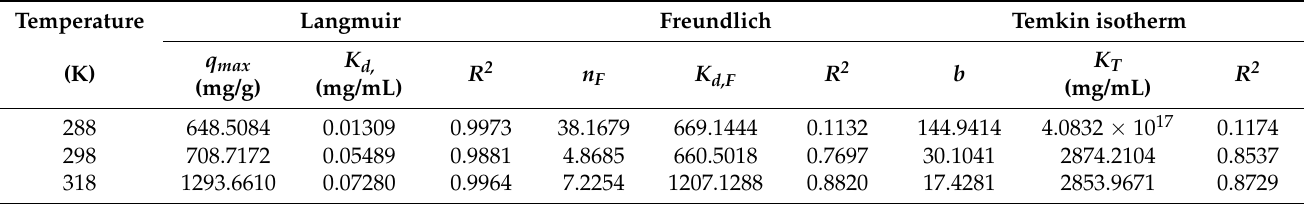
Table 4. Equilibrium and thermodynamic parameters calculated using equilibrium isotherm models for determining the adsorption behavior of P-COOH-CS-RG19 nanofiber membrane for lysozyme.